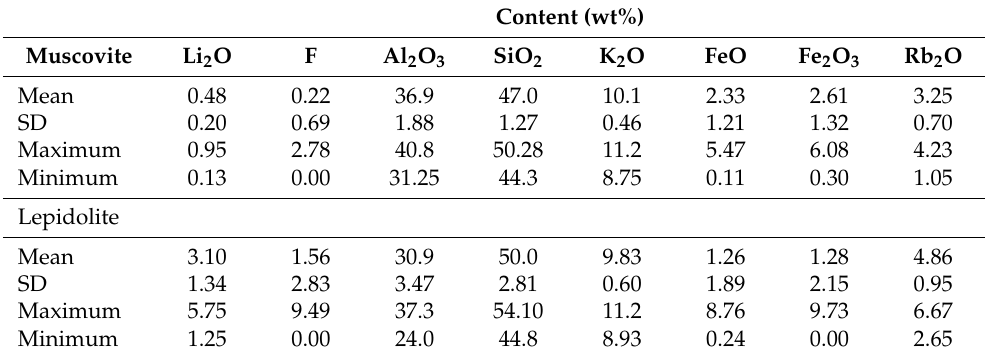
Table 6. Average composition of muscovite and lepidolite grains obtained by LA–ICPMS.